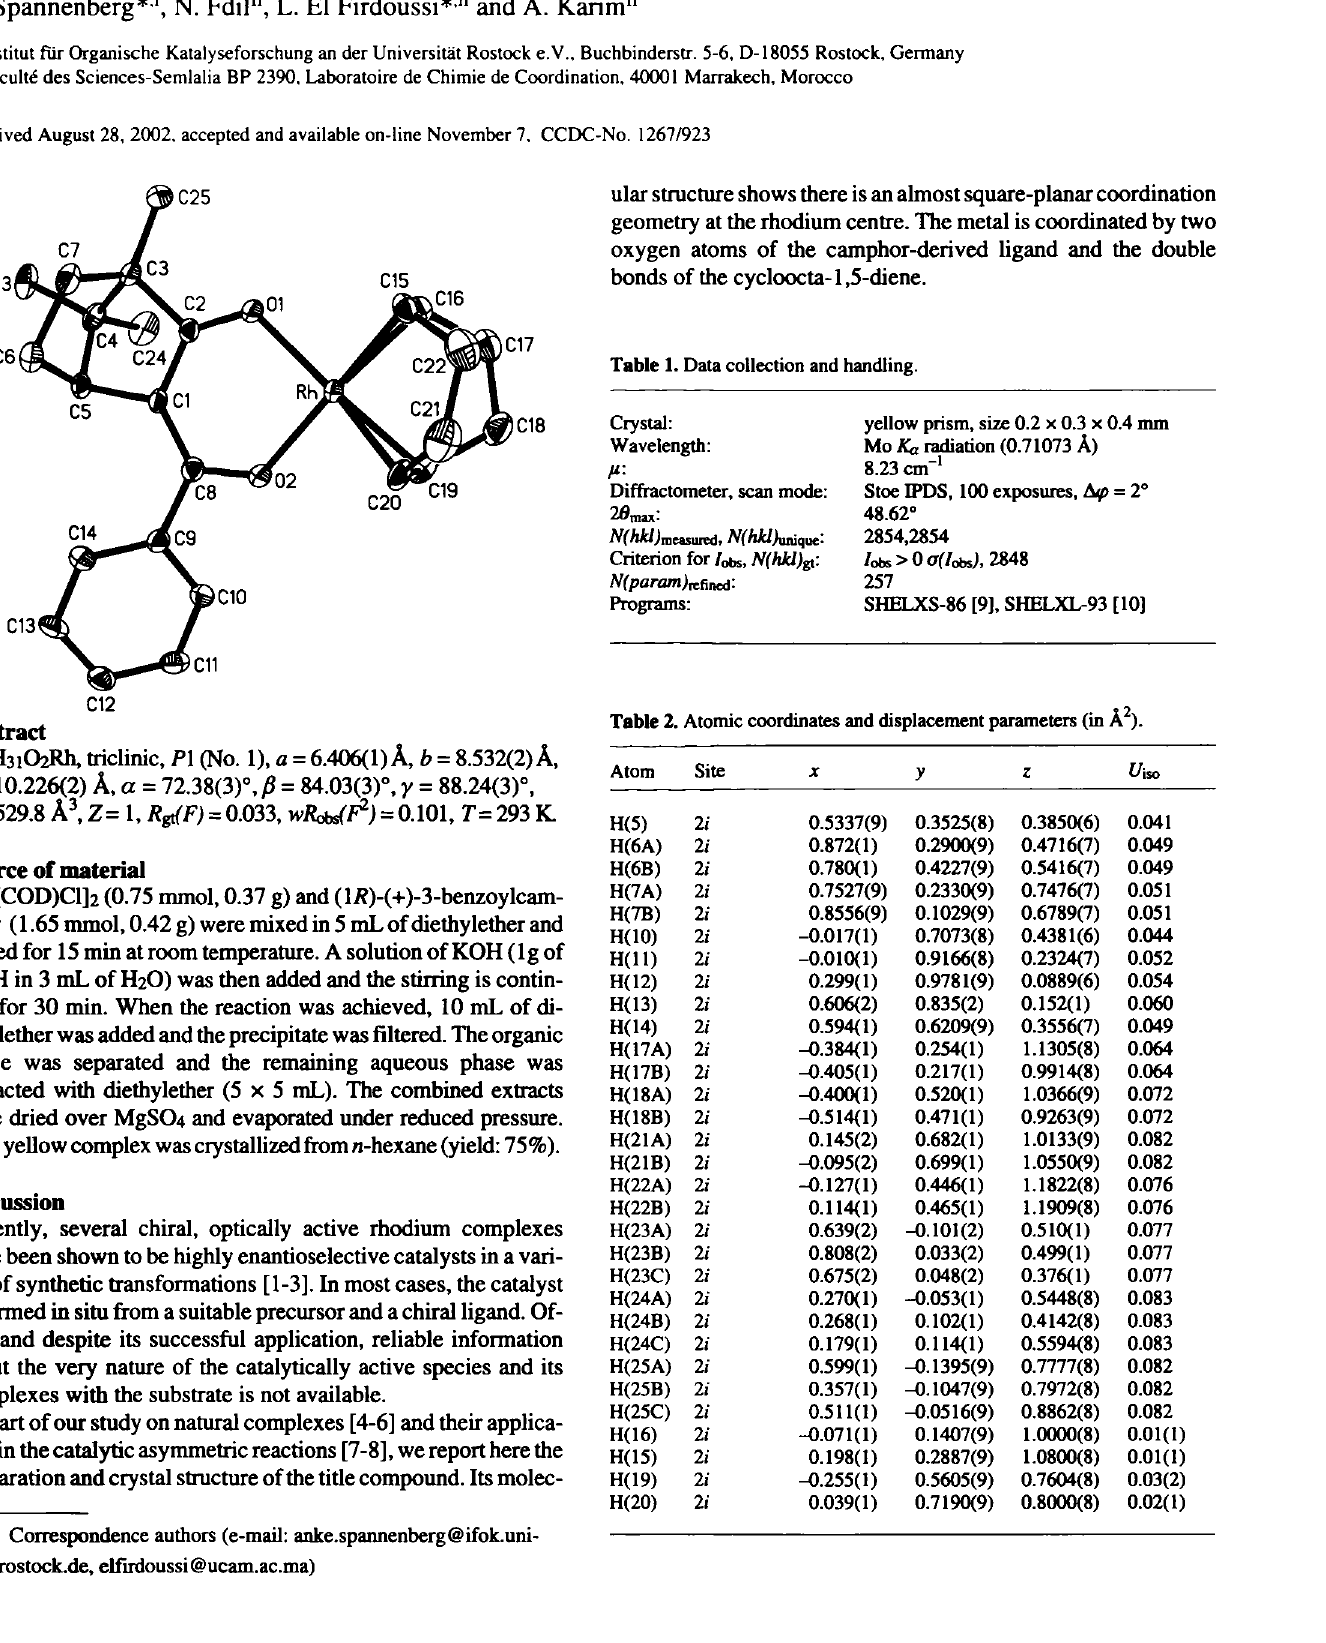
Table 1. Data collection and handling.